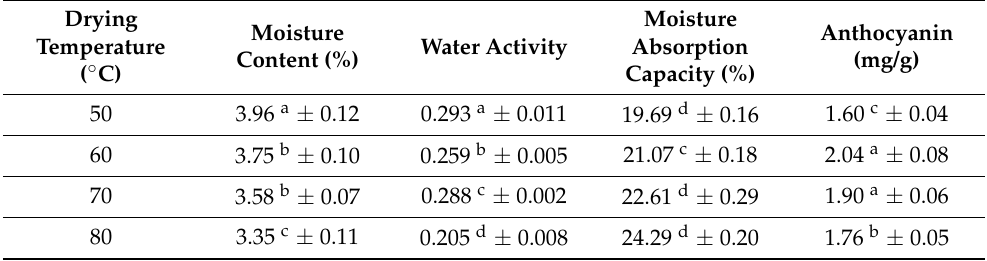
Table 7. Physical properties of foam-mat dried magenta at different drying temperatures.